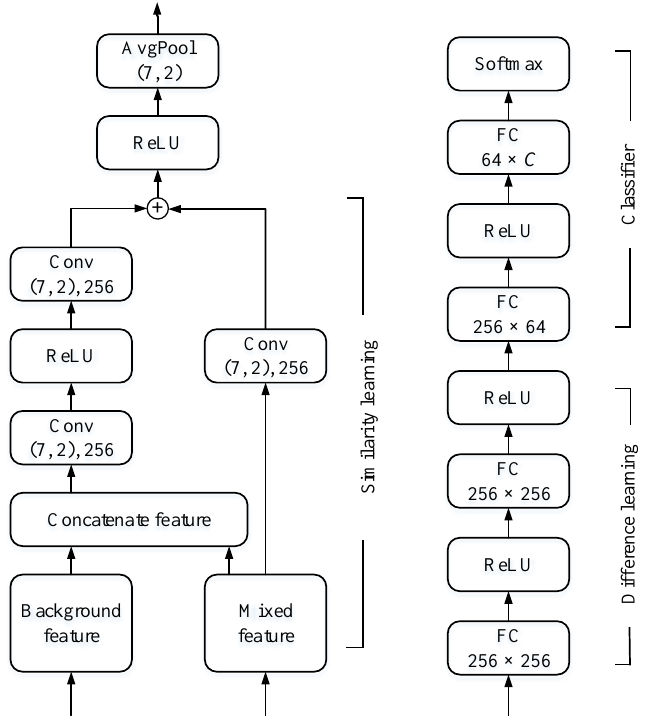
Figure 5. The detail architecture of similarity learning and difference learning module. The addition operation (cid:76) in similarity learning module is